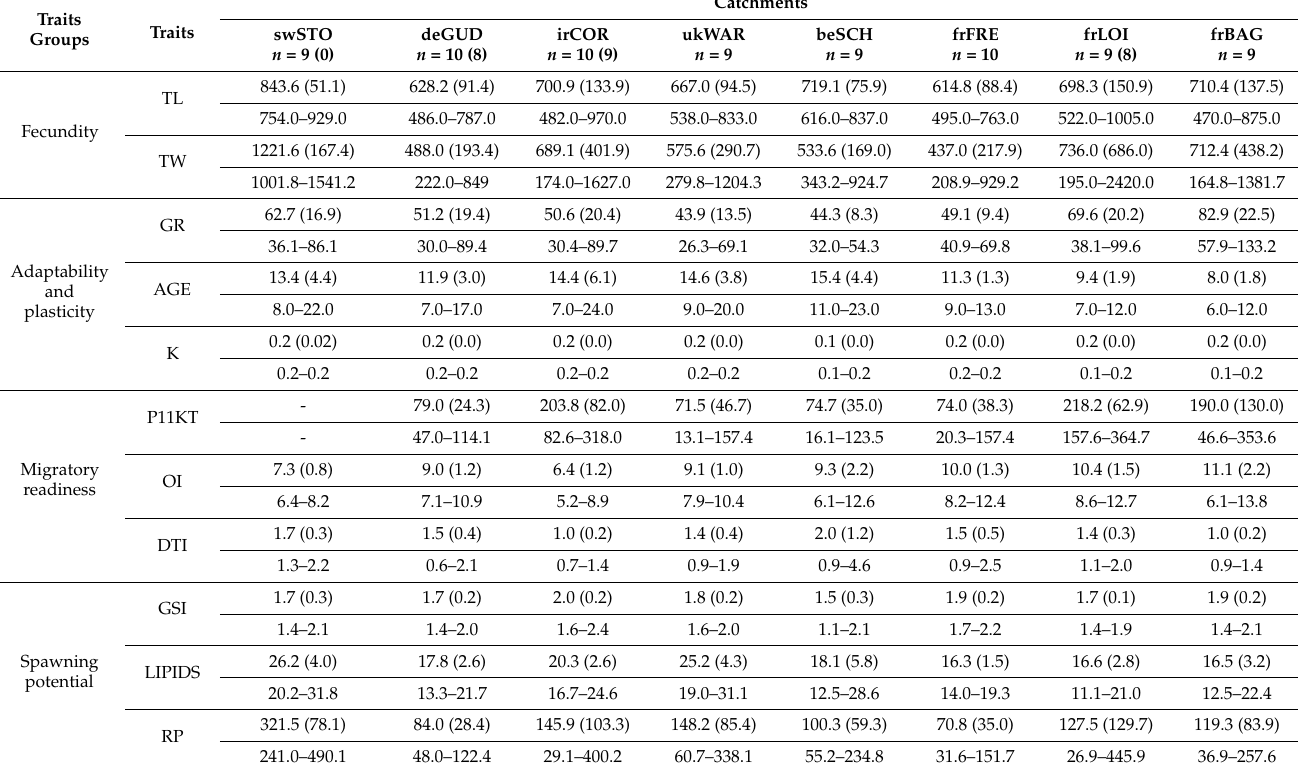
Table 2. Distribution of fitness-related traits of female silver eels by sampled